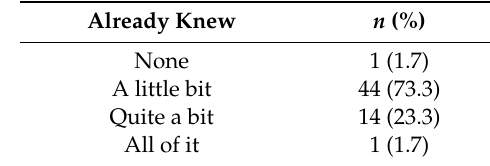
Table 6. Intervention student responses to question: How much of the course content did you already know? ( n = 60).